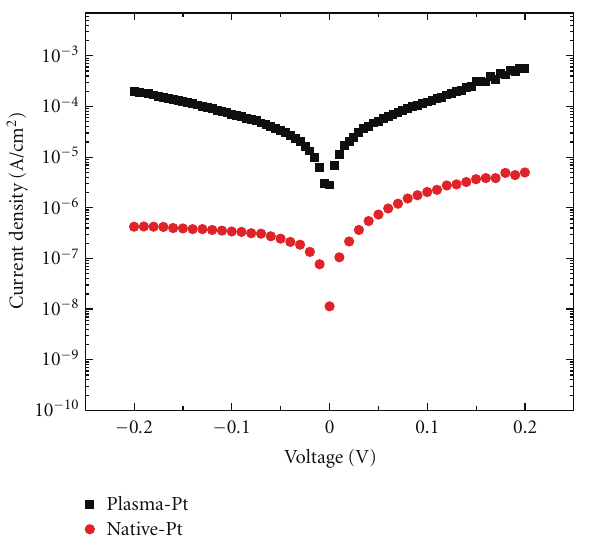
Figure 3: Comparison of current density (Logarithmic scale) of MIM Diodes made with native and Plasma TiO 2 .